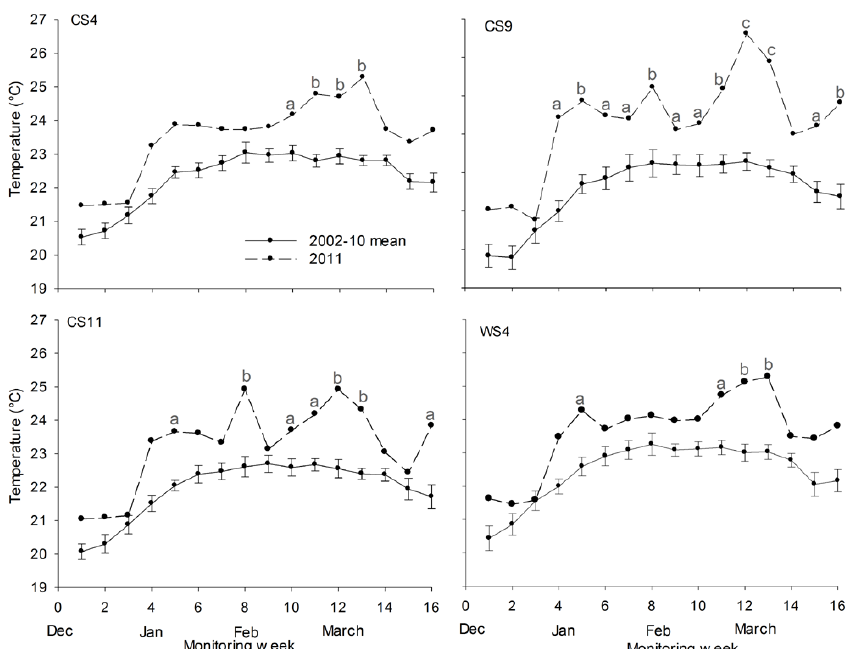
Fig. 3. Weekly bottom temperatures recorded during 2011, plotted against 2002–2010 mean temperatures ( ± SE) at each monitoring site (“monitoring week 1” relates to the first week in December). Thermal Stress Anomalies (TSAs) where weekly temperatures were ≥ 1 ◦ C higher than the warmest climatological week (i.e. mean summer maximum, 2002–2010) at each site are indicated by lower case letters;